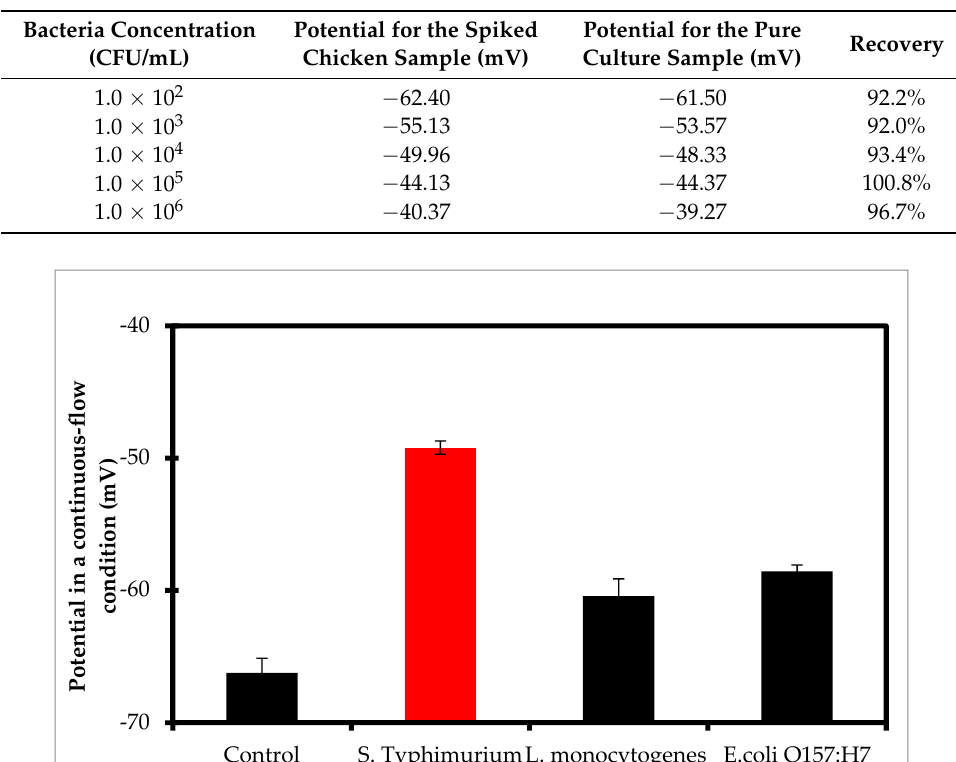
Figure 5. Specificity tests on the S. Typhimurium, Listeria monocytogenes , and Escherichia coli O157:H7 cells at the same concentration of 1.0 × 10 4 CFU/mL and the negative controls ( N =